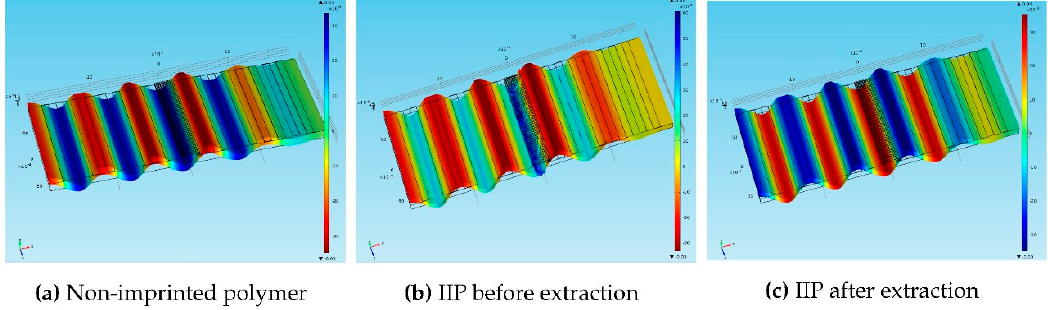
Figure 2. Snapshots of the displacement in z direction at 9.63 ps for: ( a ) the non-imprinted polymer. ( b ) the IIP before extraction. ( c ) the IIP after extraction.